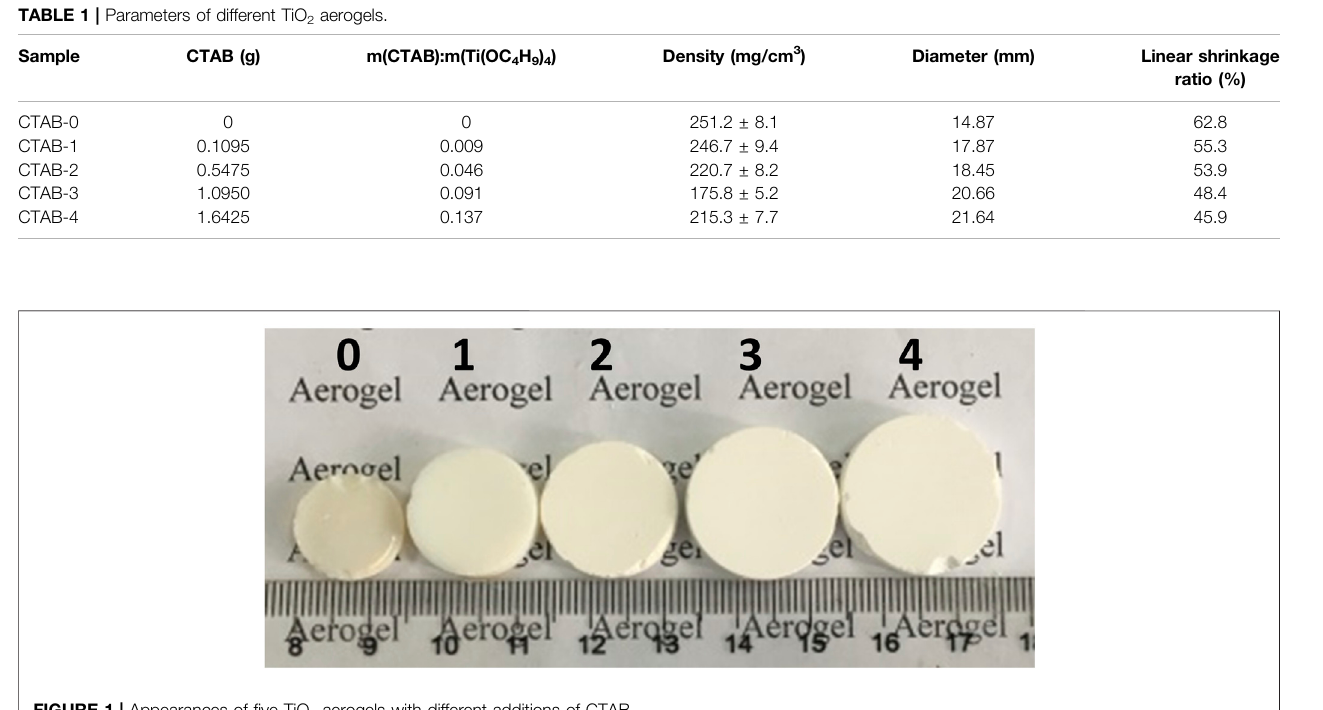
FIGURE 1 | Appearances of fi ve TiO 2 aerogels with different additions of CTAB.